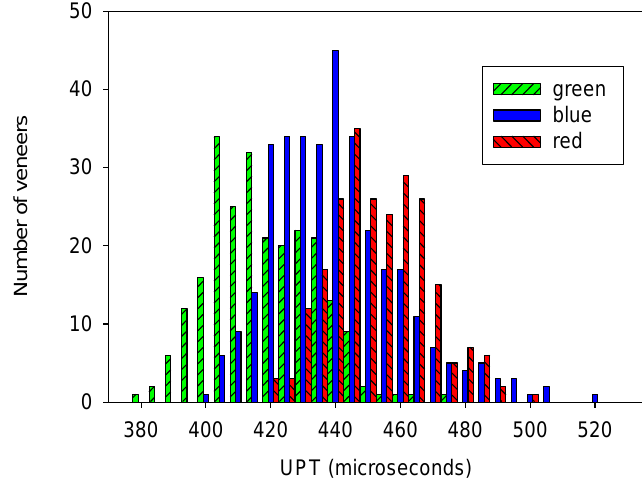
Figure 2. Number of veneers per class of ultrasonic propagation time (UPT). Results are shown for each log grade, with green being from the high velocity logs and red the